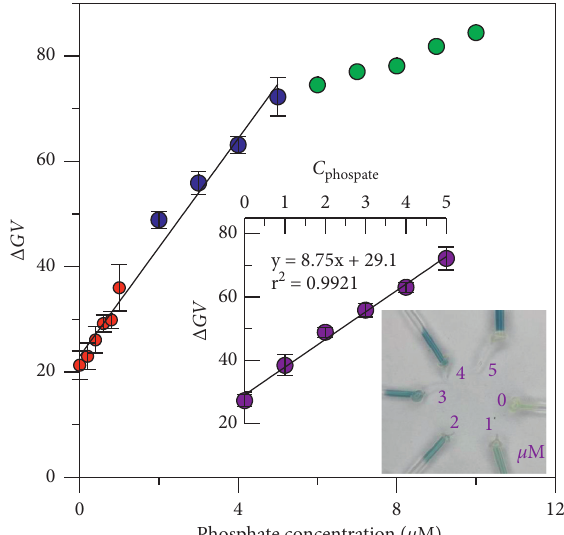
Figure 6: Calibration curves of the PMB-SPE method. Batches were color coded: red, 0–1 μ M ( n ˆ 3); blue, 2–5 μ M ( n ˆ 3); green, 6–12 μ M ( n ˆ 1); and purple (with photos), 0–5 μ M ( n ˆ